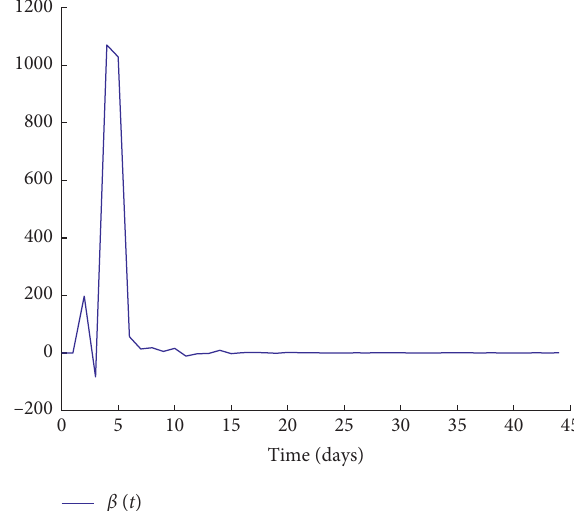
Figure 16: Estimation of the carrying capacity from reported data (Italy) and lsqcurvefit Matlab